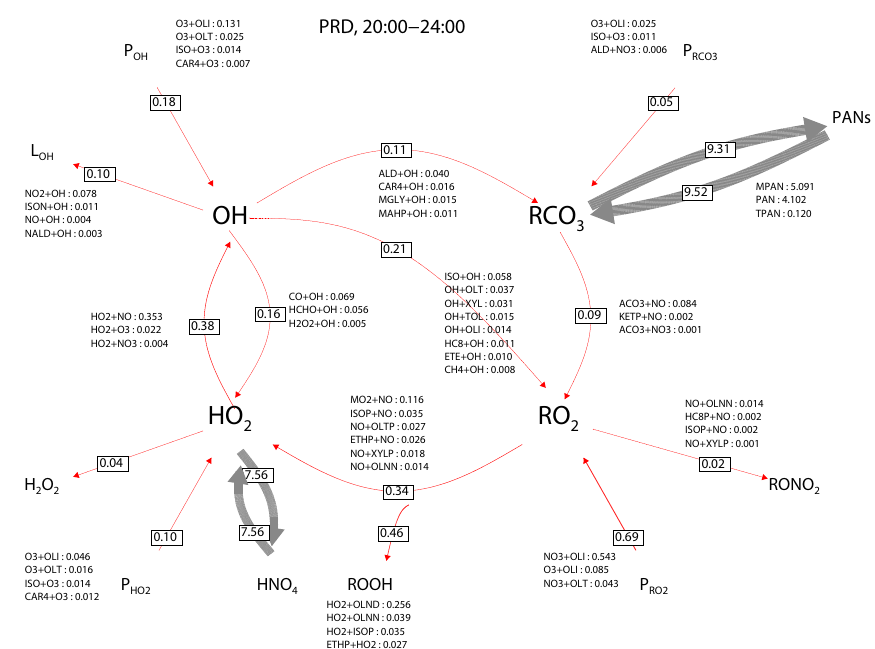
Figure 6. Mean RO x production, conversion, and destruction rates calculated by the base model (M0) for PRIDE-PRD2006 conditions during 20:00–24:00CNST. The thickness of the arrows represents the relative magnitude of the reaction rates given in ppbh − 1 .